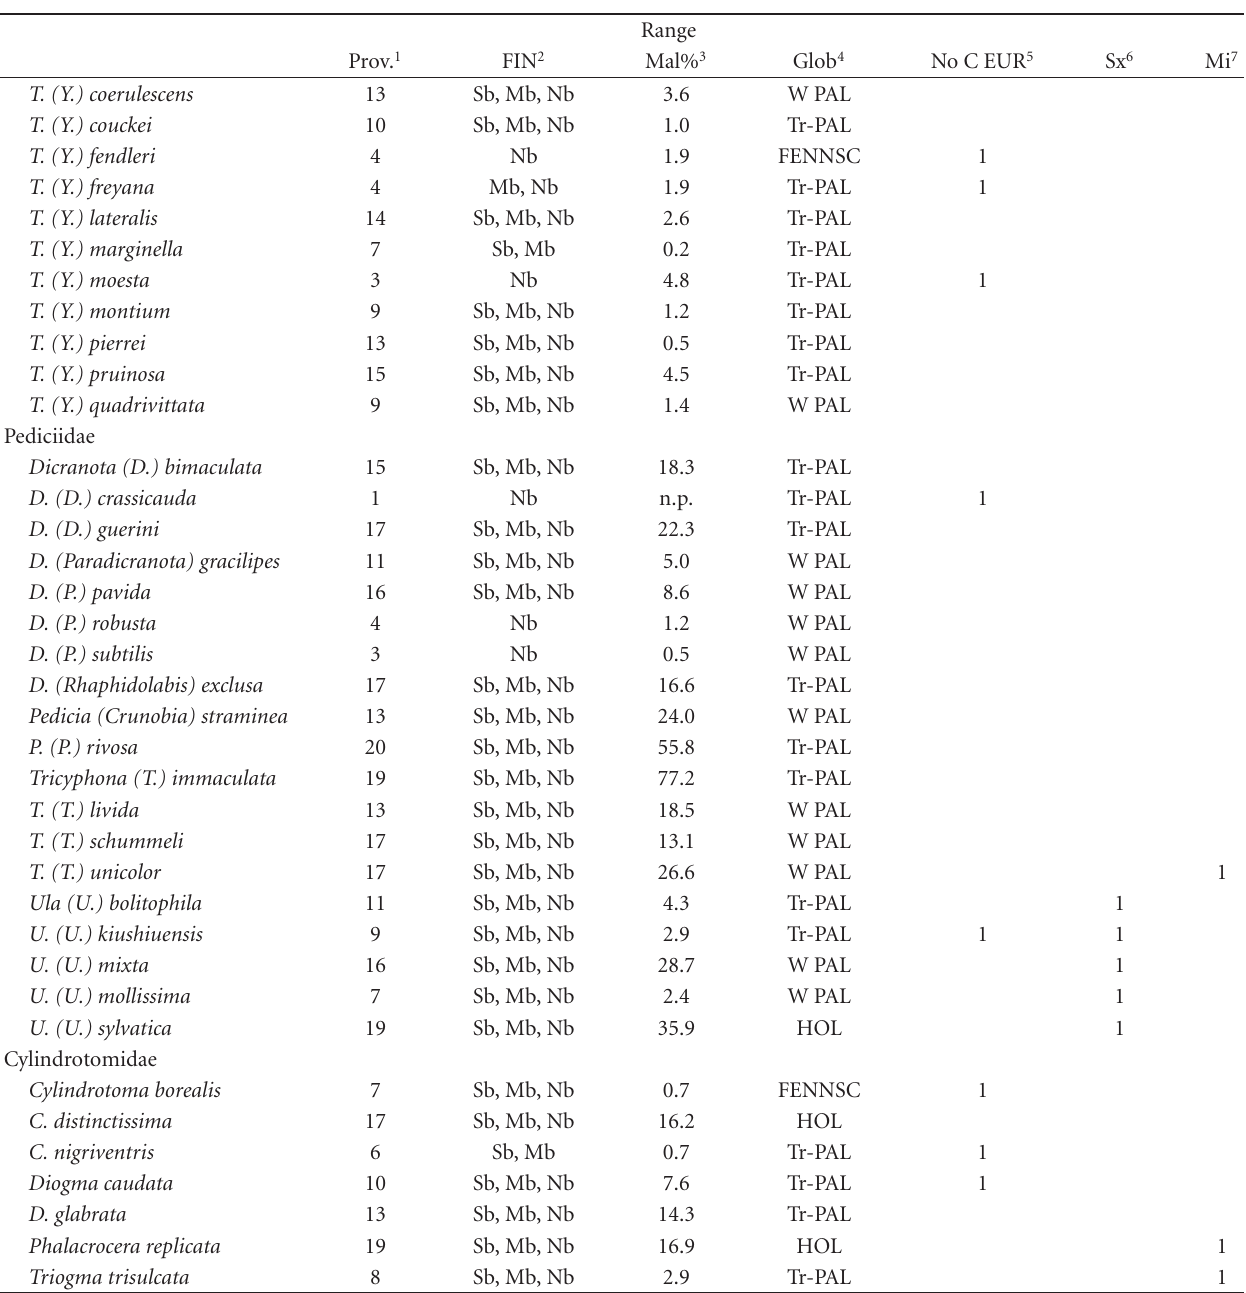
1 Number of occupied provinces in Finland. 2 Range in Finland, Sb: hemi- and south boreal, Mb: middle boreal, and Nb: north boreal zone. 3 Occupancy frequency in Finnish Malaise trapping data (out of 421 sites; some closely laying sites were combined to the sites × species matrix, that is why a smaller figure than 476 is given in the text), n.p.: not present. 4 Global range, HOL: Holarctic, Tr-PAL: Trans-Palaearctic, W PAL: West Palaearctic, and FENNSC: Fennoscandian. 5 Species not occurring in Central Europe. 6 Saproxylix and fungivorous species. 7 Mire-dwelling